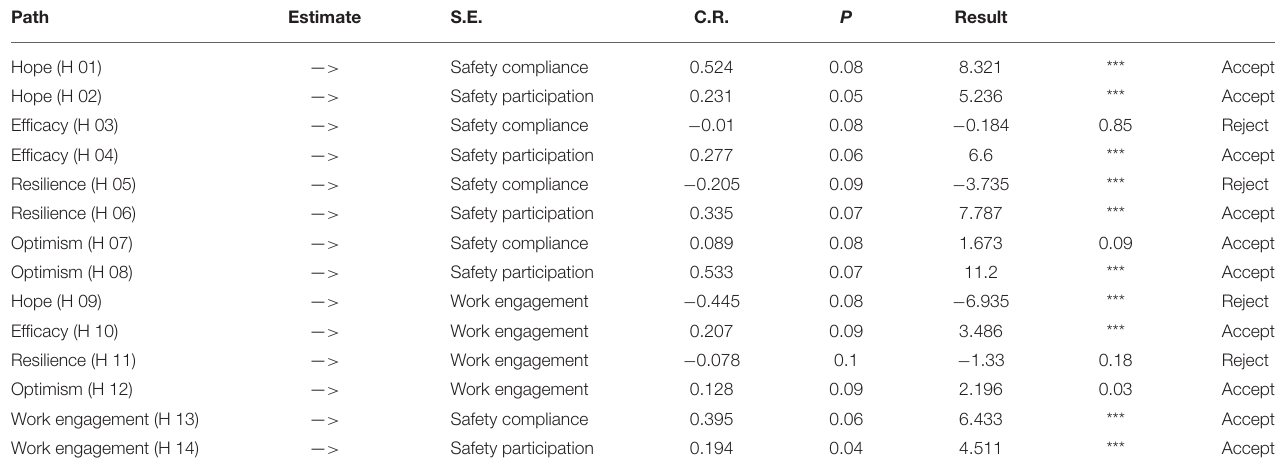
TABLE 6 | Path coefficients of the final